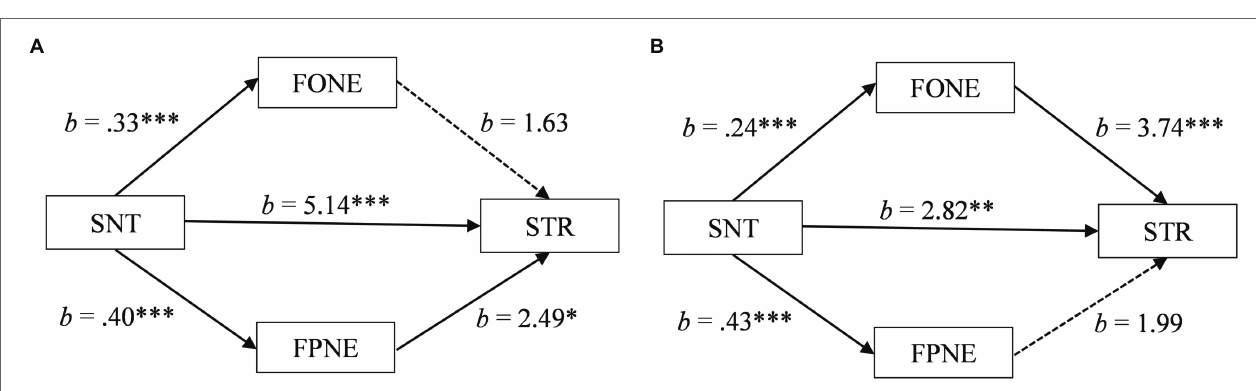
FIGURE 2 | (A) Mediation of social norm transgression (SNT) on anxiety (ANX) through fear of own negative evaluation (FONE) and fear of parental negative evaluation (FPNE) for South Asian participants. (B) Mediation of social norm transgression (SNT) on anxiety (ANX) through fear of own negative evaluation (FONE) and fear of parental negative evaluation (FPNE) for White participants. * p < 0.05, ** p < 0.01, and *** p < 0.001.